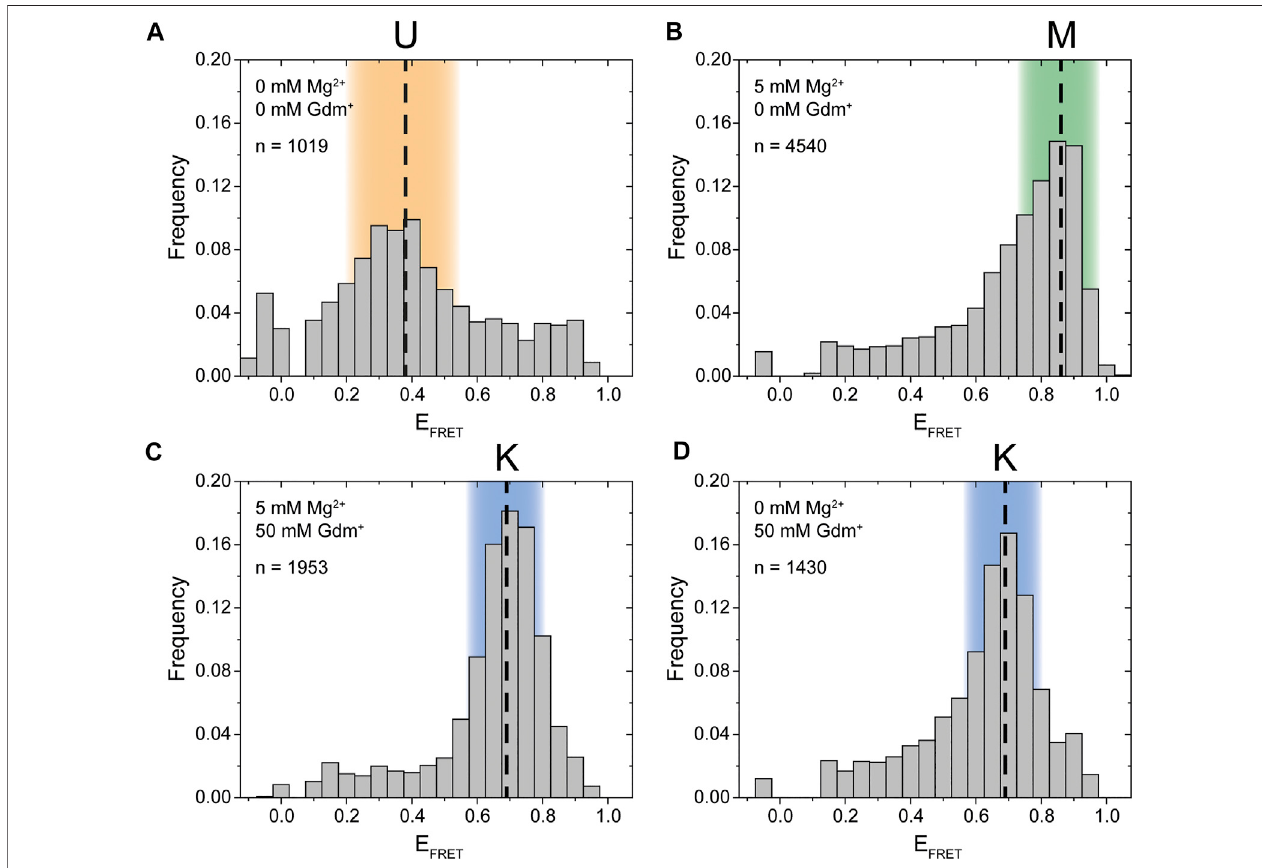
FIGURE 2 | Initial smFRET experiments. The histograms show the populations at different FRET ef fi ciencies. (A) in the absence of ions (B) with only Mg 2+ present (C) with both Mg 2+ and ligand present and (D) with only the ligand present. The U-state is highlighted in orange, the K-state in blue and the M-state in green.